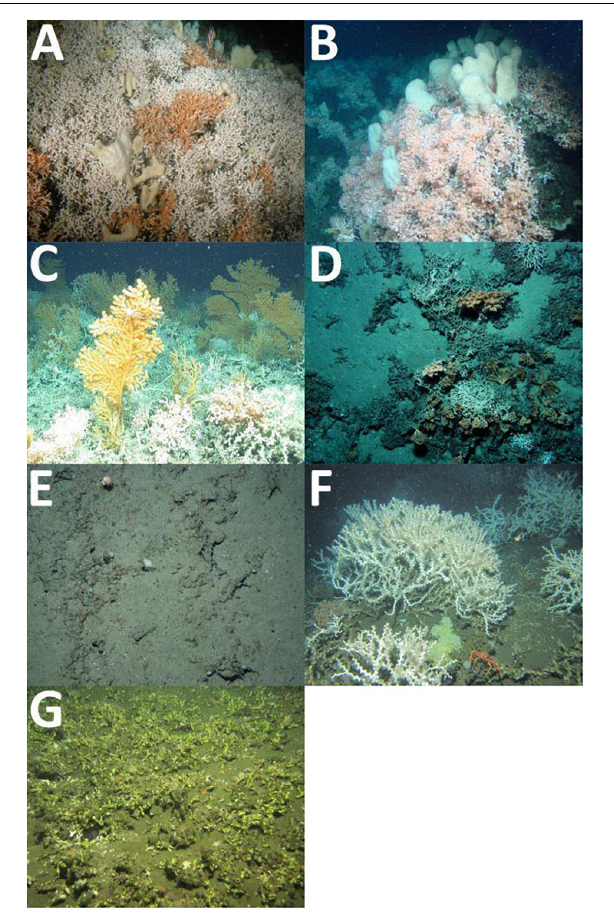
FIGURE 3 | In situ photographs of CWC sites: (A) Stjernsund, dense living D. pertusum colonies with sponges (Freiwald and Dullo, 2014), (B) Nordleksa, living D. pertusum colonies with sponges (Form et al., 2015), (C) Galway Mound, dense CWC reef,© MARUM University of Bremen, (D) St. Nazaire Canyon, single coral colonies, (E) Pagés Escarpment, coral rubble, (F) Valentine Mounds, living D. pertusum colonies (mound top) with sponges © MARUM University of Bremen (2016), (G) Sylvester Mound, dead coral framework with dense colonization of yellow bryozoans, actiniarians and sponges © MARUM University of Bremen